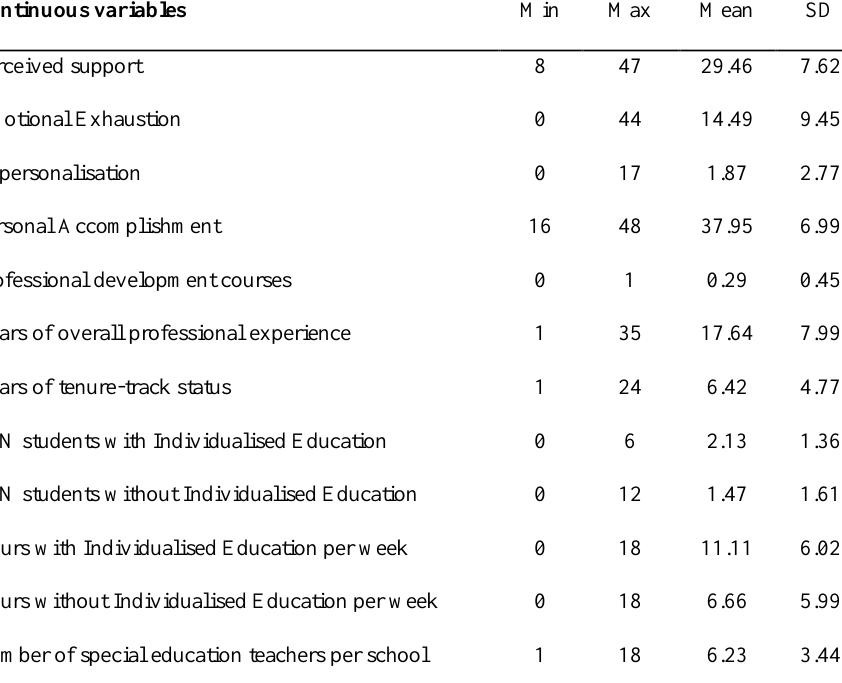
Descriptive statistics for the variables used in the analyses (N=276) Continuous